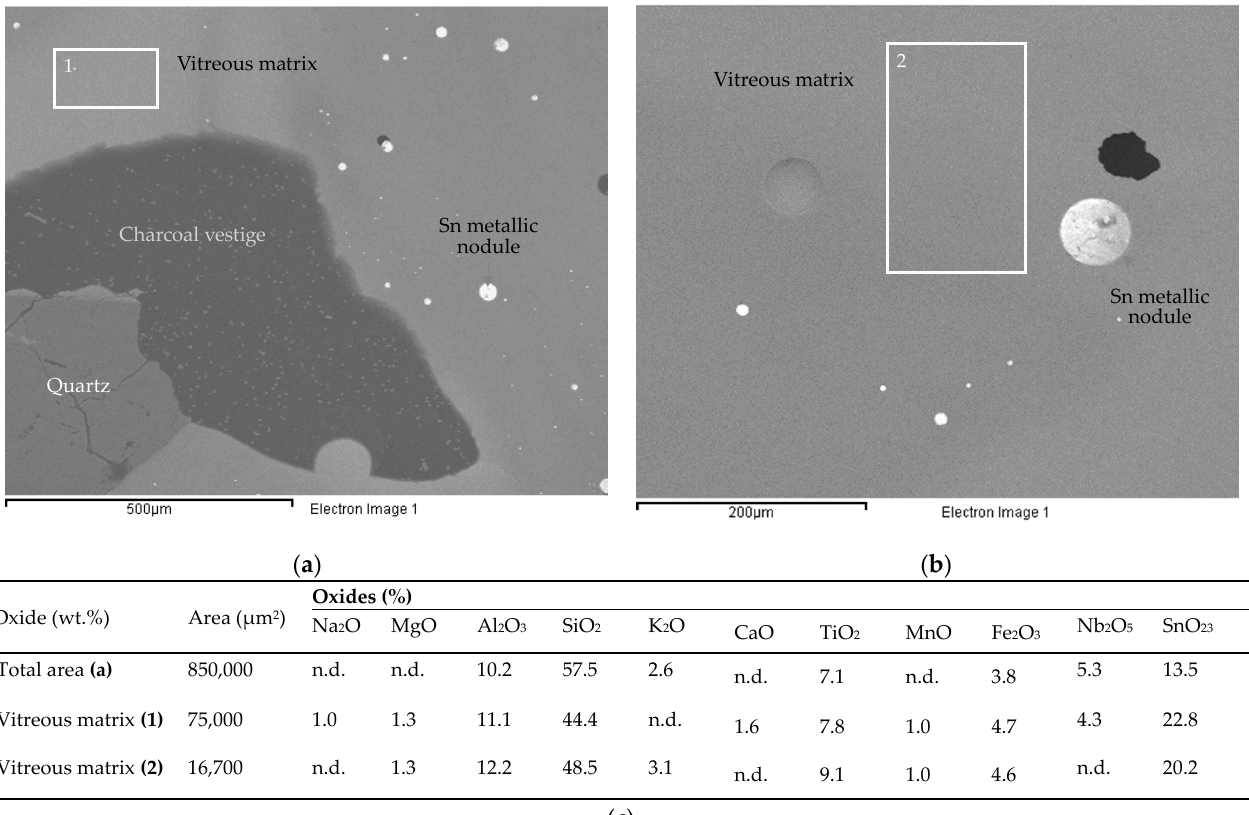
Figure 9. SEM-EDS analysis of the tin slag material: ( a ) BSE image of area showing gangue remains (such as quartz) from the cassiterite ores and charcoal from the smelting process among a vitreous matrix with numerous Sn (metallic) nodules; ( b ) BSE image of another area showing the vitreous matrix and Sn (metallic) nodules of various sizes and ( c ) EDS results of chemical composition of annotated areas.